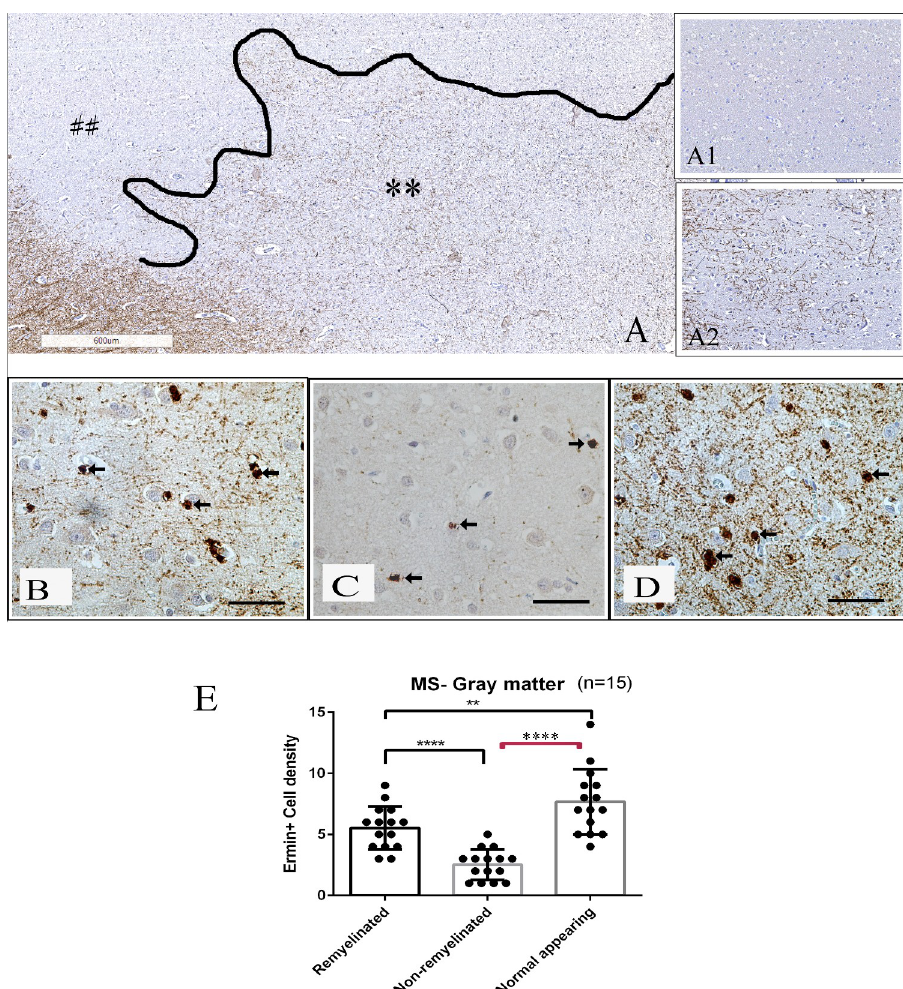
Fig 4. Ermin positive cell density in MS gray matter lesions. (A) Myelin proteolipid protein (PLP) stained tissue section ( �� represents remyelinated area, demyelinated area is represented by ##); the insertion A1 shows an area of complete demyelination in gray matter. The insertion A2 shows partial remyelination. (B–D) Single-label immunohistochemistry for ermin in regions of remyelinated (B), non-remyelinated (C) and normal-appearing (D) gray matter tissue from MS brain, immunopositive cells are marked with arrows. (E) The graph presents ermin+ cell density profile in remyelinated, non-remyelinated and normal-appearing regions in gray matter. Ermin+ cell density was increased in remyelinated gray matter lesion areas compared to non-remyelinated gray matter lesion areas (p < 0.0001), but was lower compared to normal-appearing gray matter (p < 0.01). Scale bar = 50 μ m, ���� : p < 0.00001, �� : p <